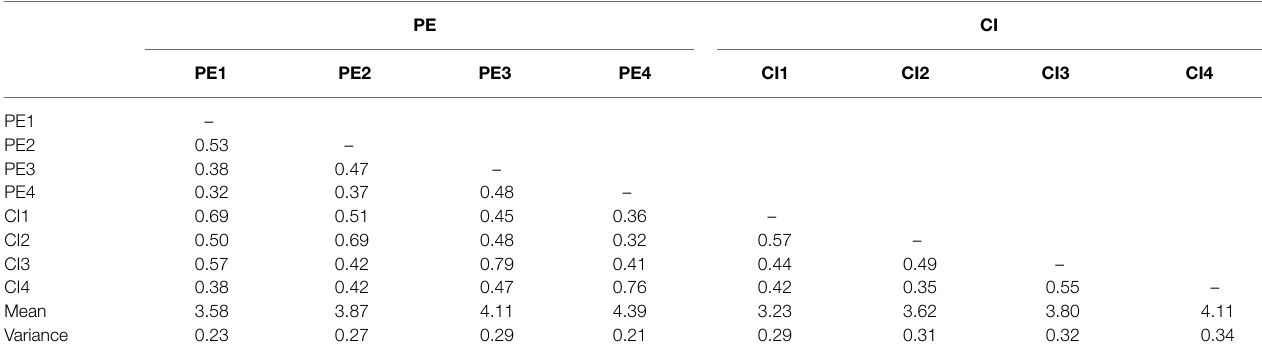
TABLE 1 | Correlation matrix between subdomains. PE